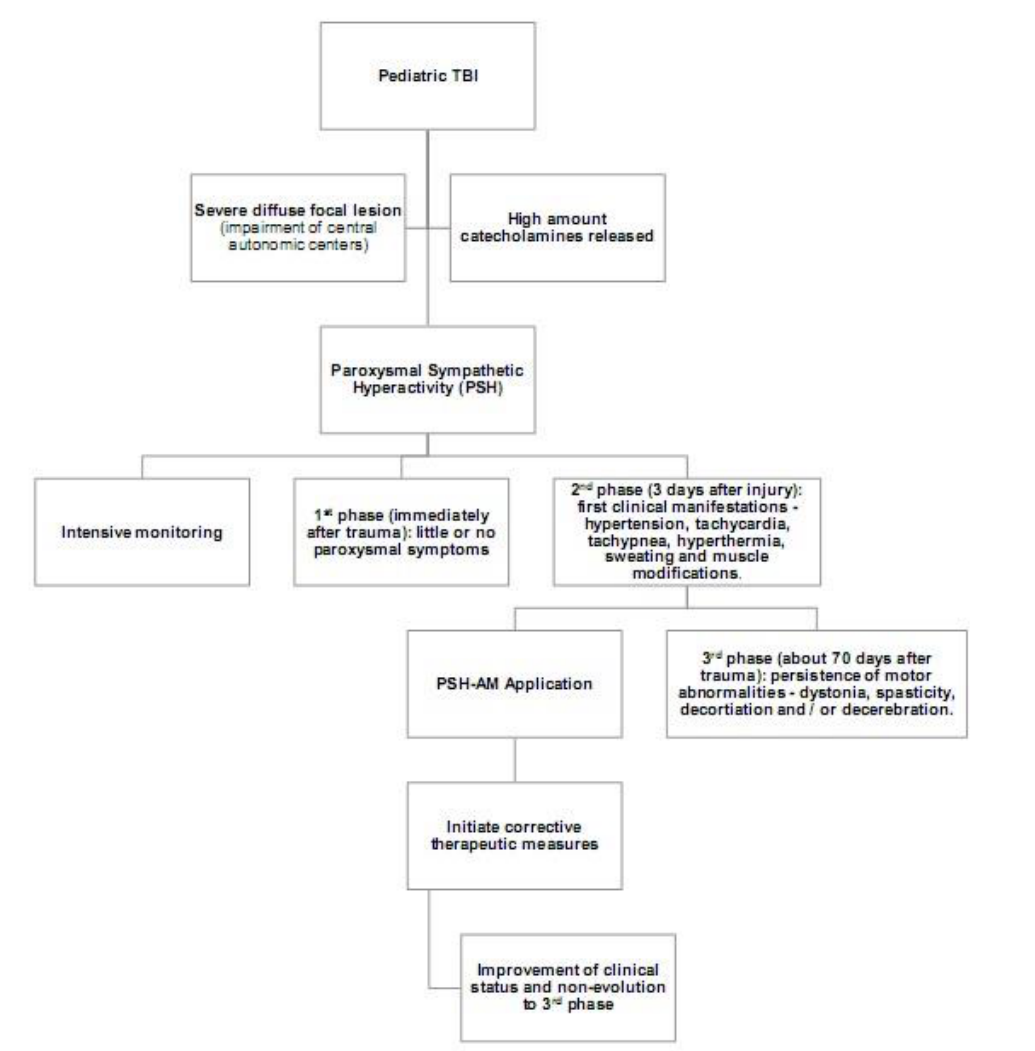
Figure 1: Pathophysiological algorithm of the